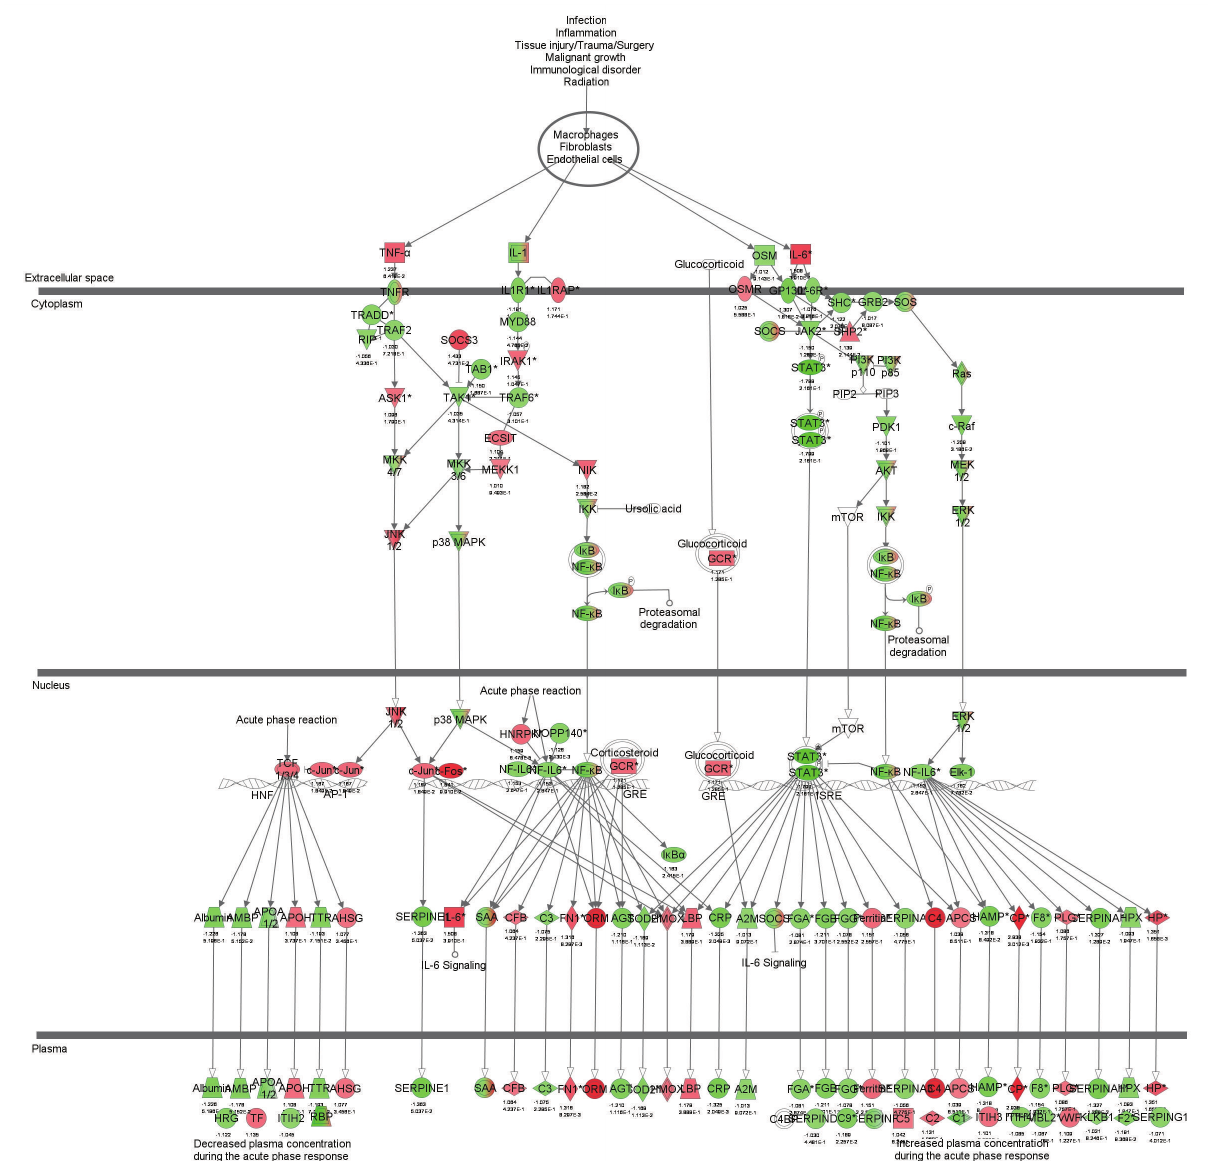
Figure 4: Acute-phase response signaling pathway (IPA) expression in the mammary tissue of lactating mice fed trans -10, cis -12-CLA. Green indicates downregulation while red indicates